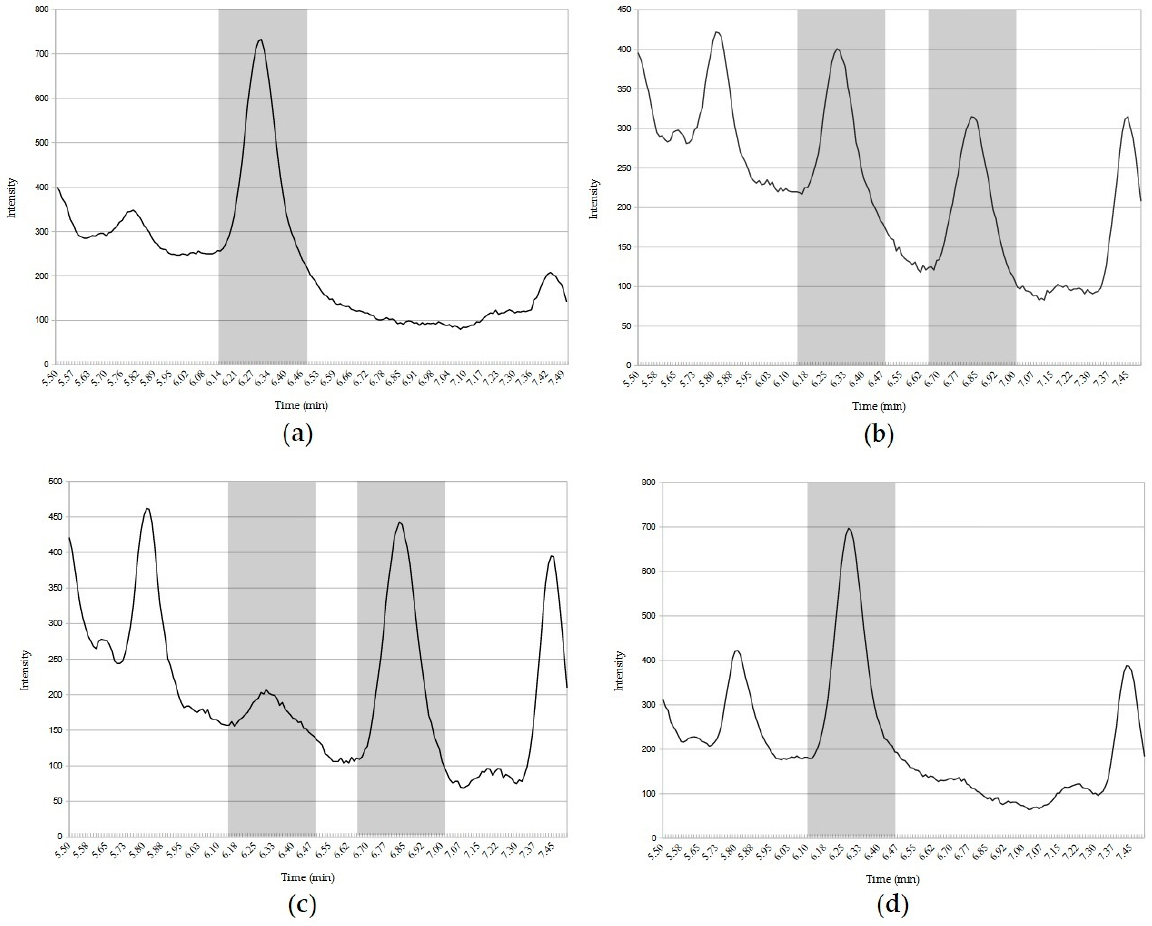
Figure 6. Combined chromatograms of yeast strains cultivated with 300 ng.mL − 1 MCs in medium. Highlighted peak at 6.36 min represents MCs extracts confirmed by comparison with MC-LR standard. The second highlighted peak area on 6.87 min is suggested to be the linearized MC. ( a )—initial point/YPD medium added with MCs before yeast inoculation (0 h); ( b )—recombinant yeast (PE-